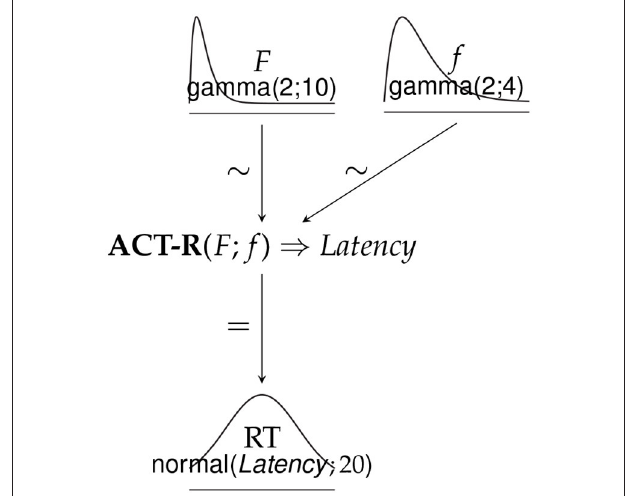
FIGURE 4 | Bayesian model for parameter estimation of Natural Stories Corpus.